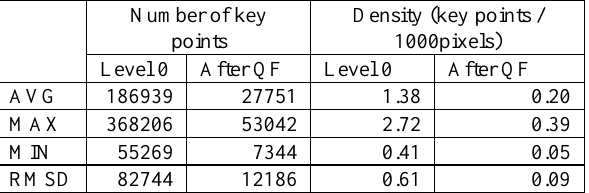
Table 3. Number and density of key points without and with